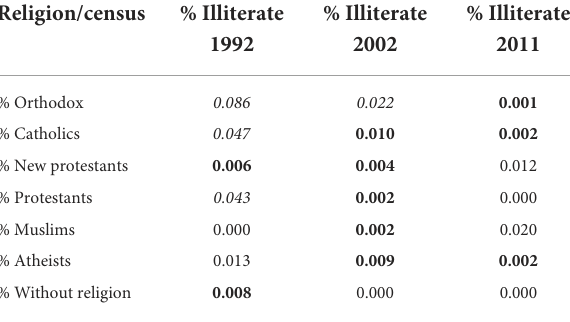
TABLE 6 Determination coefficient for Pearson correlation between the illiteracy ratio and religion